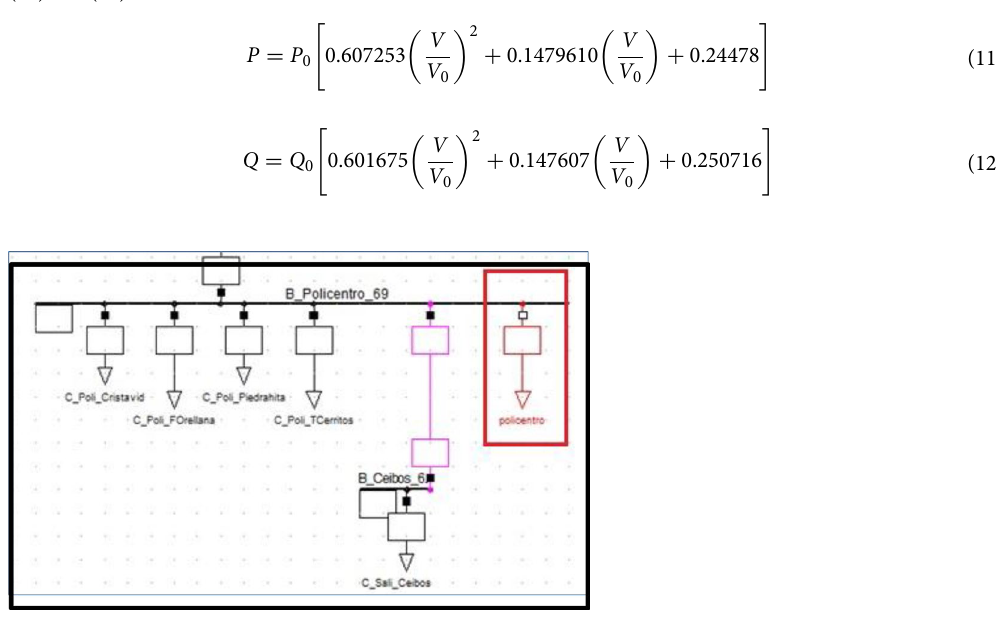
Figure 4. Policentro static (generic) load model representation.